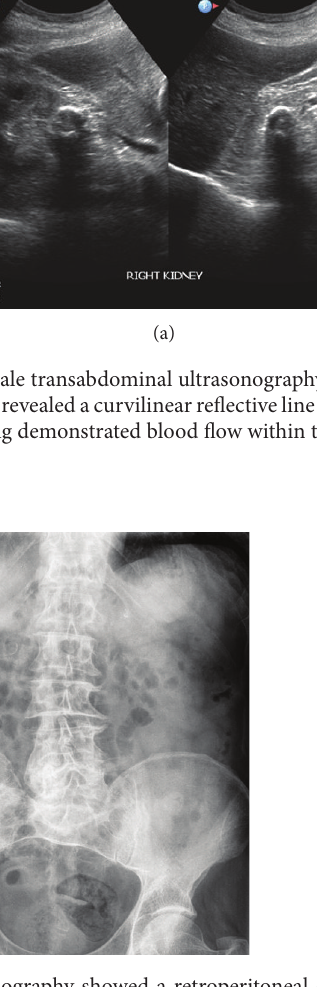
Figure 2: This KUB radiography showed a retroperitoneal curvi- linear calcification with discontinuous border, which lied near the right transverse process of the second lumbar vertebra (arrow). This calcification correlated with the ultrasonographically detected pararenal vascular structure with wall